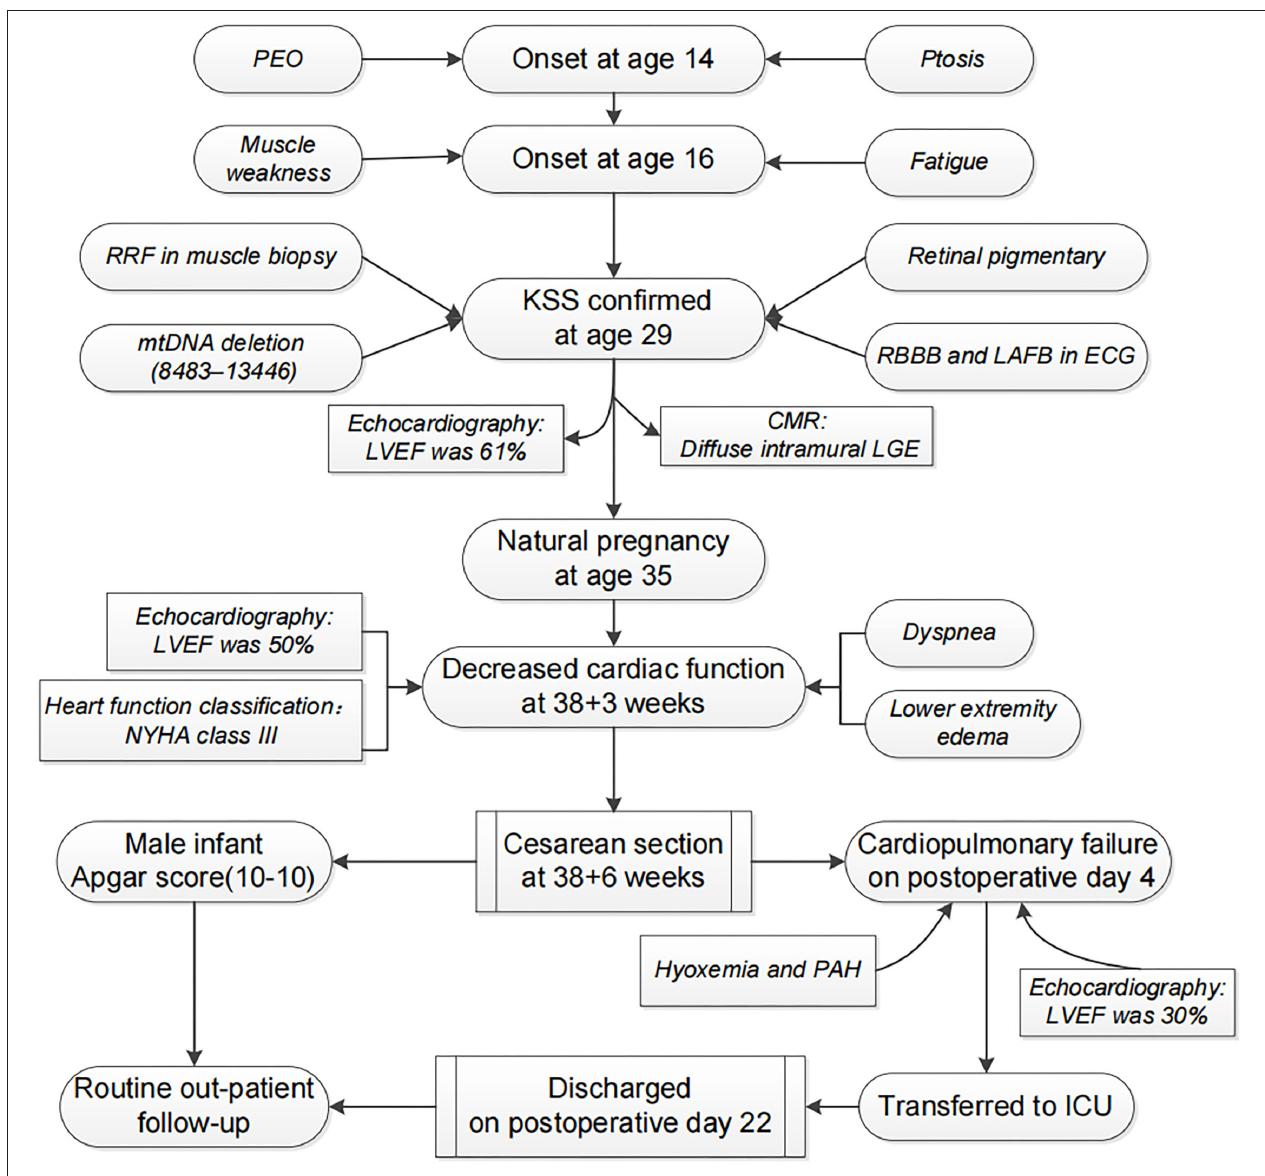
FIGURE 1 | A schematic diagram of the progression of disease in the current